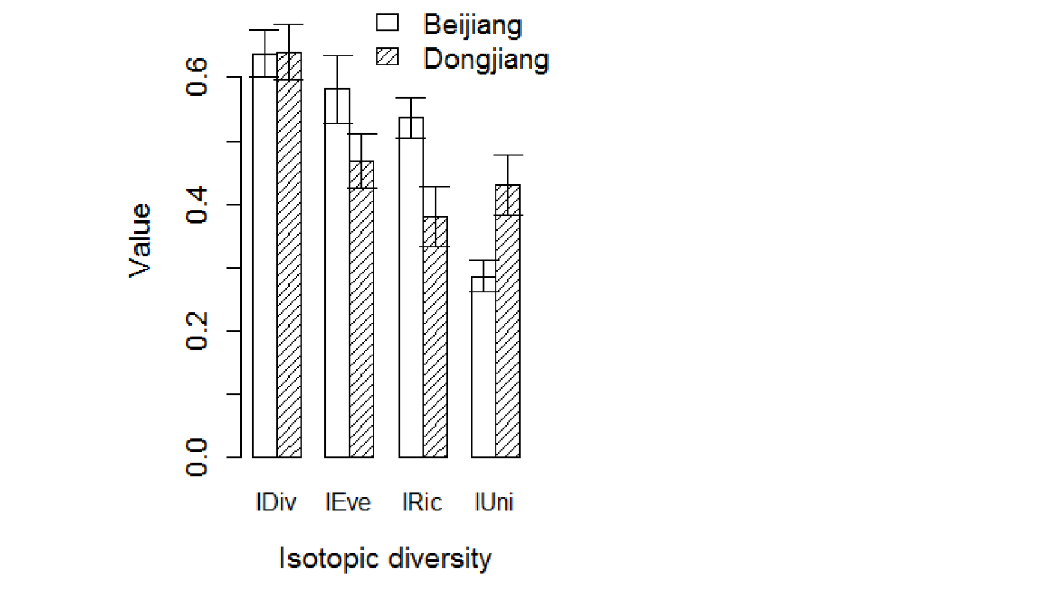
Figure 5. Differences in isotopic diversity index in the invaded Dongjiang River and the reference Beijiang River. IDiv, isotopic divergence; IRic, isotopic richness; IEve, isotopic evenness; IUni, isotopic uniqueness.